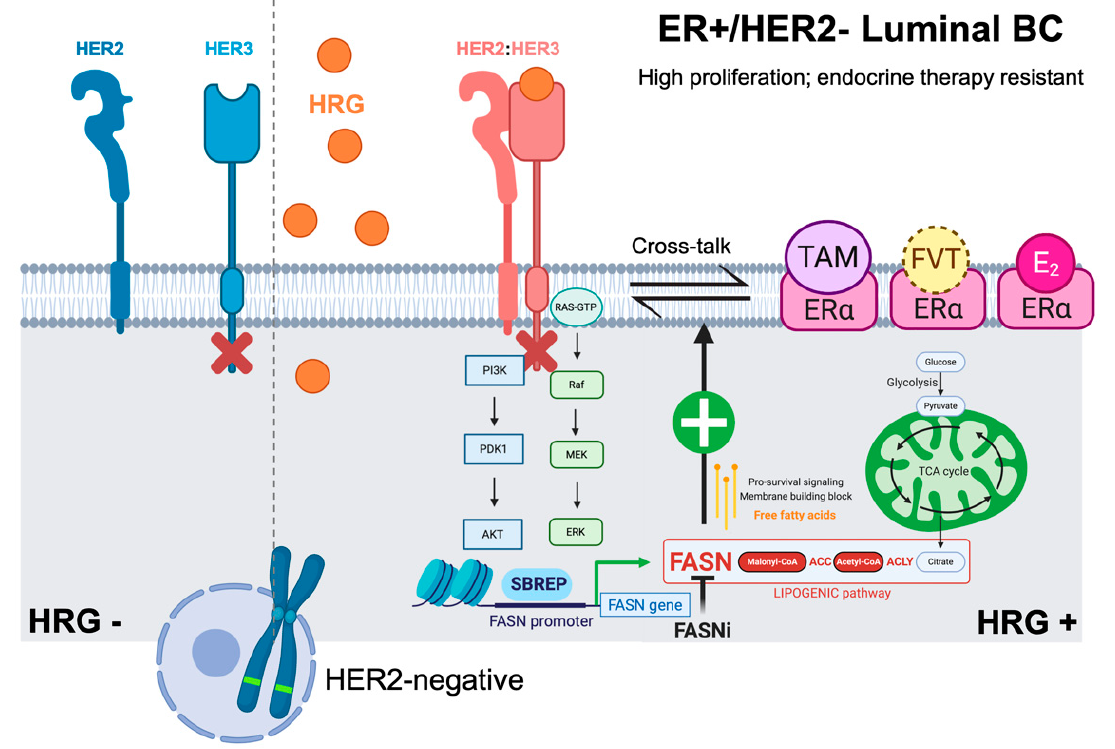
Figure 5. FASN is part of the endocrine resistance program in HRG-positive/HER2-negative breast cancer cells. The most predominant mechanisms of endocrine therapy resistance in estrogen receptor-positive (ER+) breast cancer include interaction between ER signaling and various growth factor pathways such as HRG-driven transactivation of HER signaling in the absence of HER2 overexpression. These alterations facilitate adaptation from estradiol-dependent to estradiol-independent ER activation, which is further triggered by cross-talk with growth factor receptors (e.g., HRG-driven HER2:HER3 heterodimerization). We now provide evidence that FASN is a key mediator in promoting HRG-driven endocrine-resistant breast cancer.